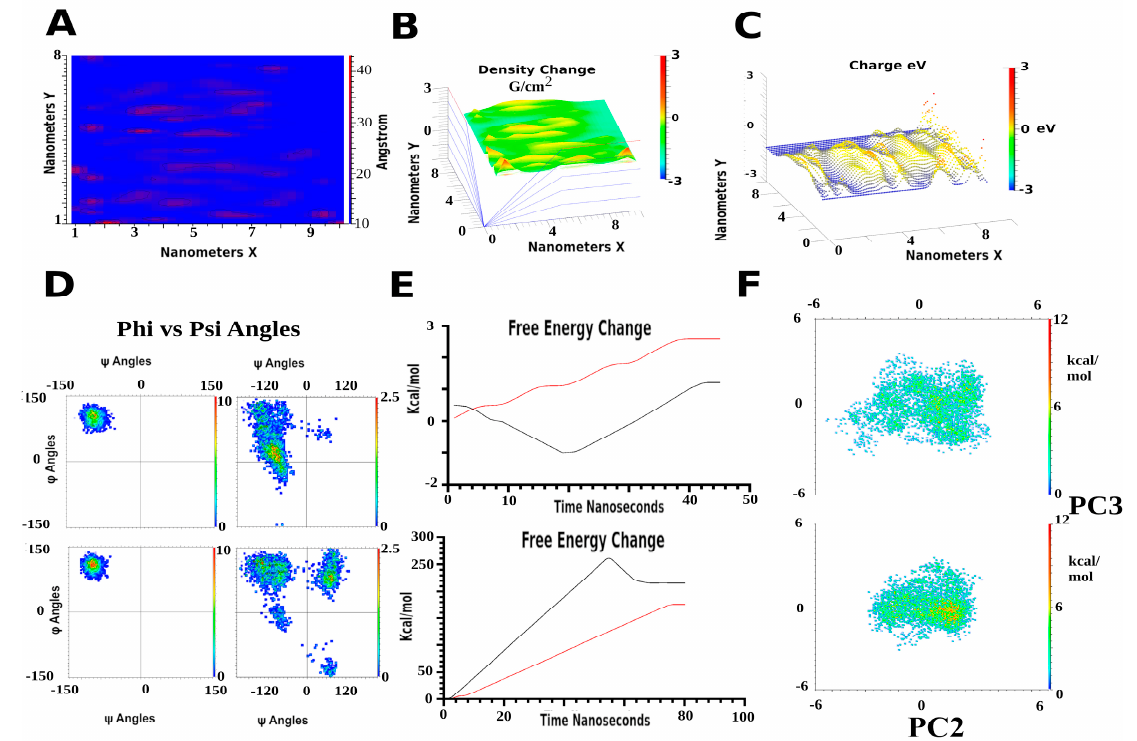
Figure 4. Common methods of data presentation. ( A ) Surface maps can be used to highlight differences based on a range of colors, including contour lines and changes between areas. ( B ) A 3D heat map graph, often used to highlight a range of data from density, thickness and charge to lipid clustering and type. ( C ) Another 3D graph type consisting of graduated lines often used to look at thickness and charge. In many cases, the graphs in ( A – C ) can be used to represent different data in a number of user ‐ specific ways. ( D ) Phi ‐ Psi dihedral angle change plots (Ramachandran) for a non ‐ interacting, left, and interacting amino acid, right. The top and bottom are with and without the small molecule ligand. These graphs were often used in NMR, X ‐ ray and earlier MD studies to identify important residues over proteins, especially in lieu of graphics software. The technique is also applicable to lipids, especially cofactors or ligands, but has been more often utilized recently by AI driven data mining. ( E ) Simple free energy change graphs for small molecules, top, and proteins, bottom. Proteins in some cases mirror the small molecules. In the top, red shows a multi ‐ ordered affinity, which can be missed without pulled simulations when determining kinetics. The top, black, shows a small molecule which has a large energy barrier, even though the process is energetically favorable. The bottom, red, shows a very straightforward normal kinetic which has no hidden aspects, while the bottom, black, details a common aspect of membrane attracted proteins, an initial energy drop, before binding, due usually to hydrophobic residue interactions. ( F ) The most common representations, a PC plot of the energy motion eigenvectors for a protein, here binding a membrane. The top shows a membrane with 1% cholesterol, and the bottom 5%. The total energy for the protein interacting with the membrane is shown as the heat maps, highlighting more focused interactions from the protein’s bottom with 5% cholesterol. Data in ( A , B , C , E ) are test data for graphing; data in ( D , F ) are real experimental data (author).